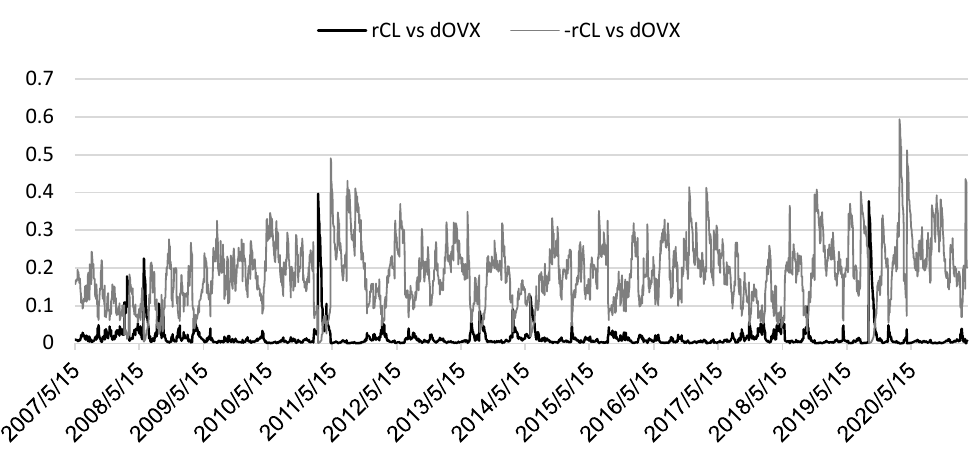
Figure 4. Estimation of the tail dependence coefficient for the relationship between Crude Oil Future Contract returns (rCL)/negative returns (−rCL) and changes in the CBOE Crude Oil Volatility Index (dOVX) in the entire period.